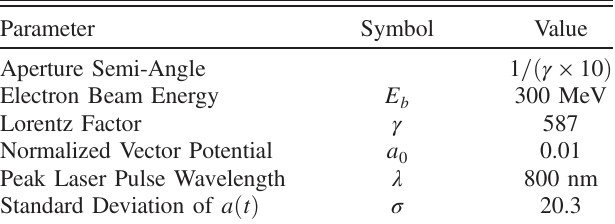
TABLE II. Parameters used in the backscattering spectra. These parameters are very similar to the Ghebregziabher et al. [8] but the normalized vector potential has been reduced to bring the scattering event into the linear regime and eliminate the ponder- omotive red shift and broadening.